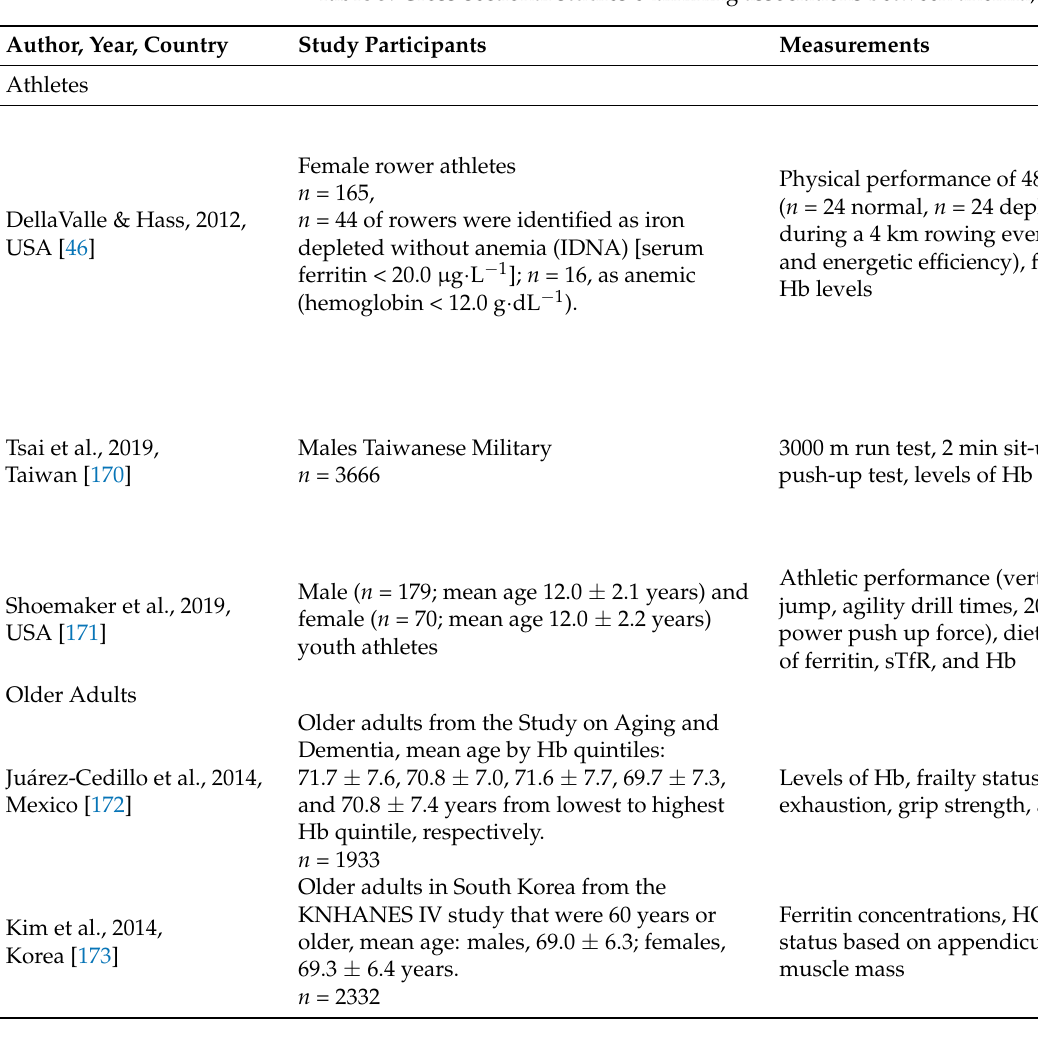
Table 3. Cross-sectional studies examining associations between anemia, iron status and muscle